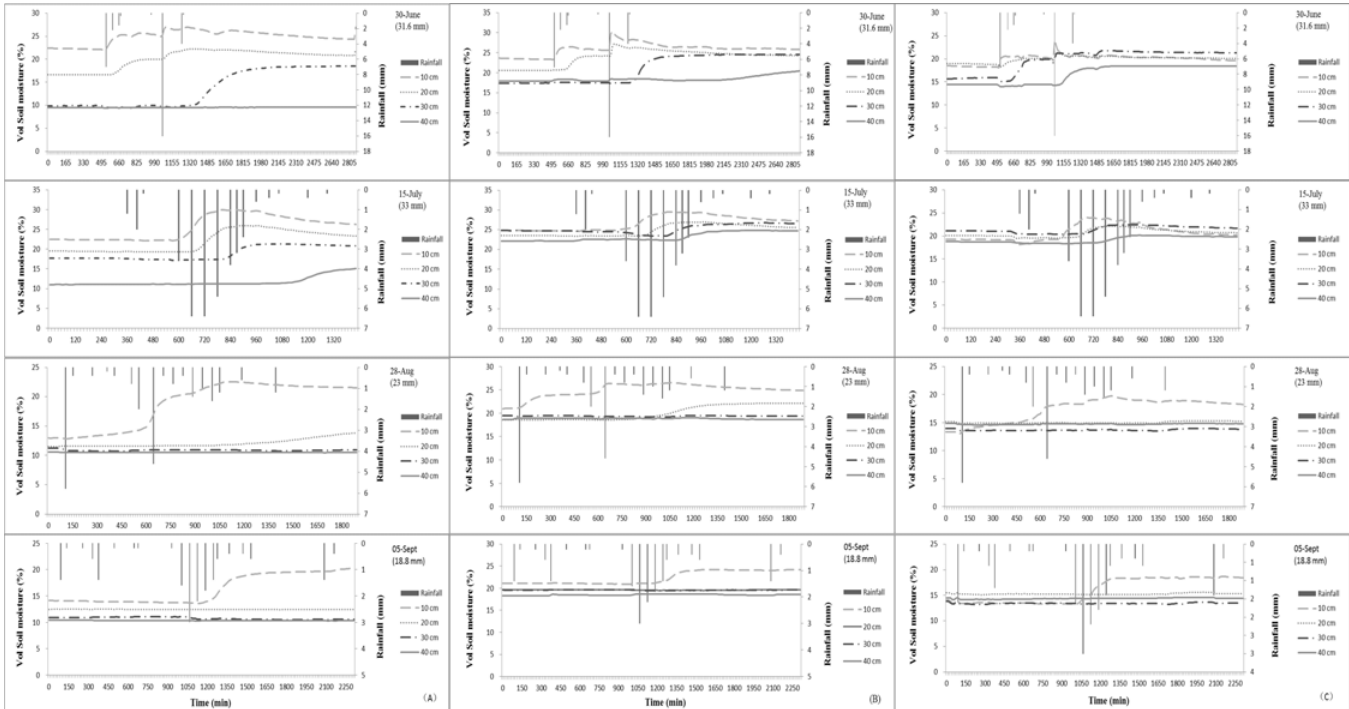
Fig 4. Fluctuation of soil-moisture content with rainfall for the three vegetation types for four single rains. (A) Soil-moisture content of artificial Larix spp., (B) soil-moisture content of Quercus mongolica , and (C) soil-moisture content of unused